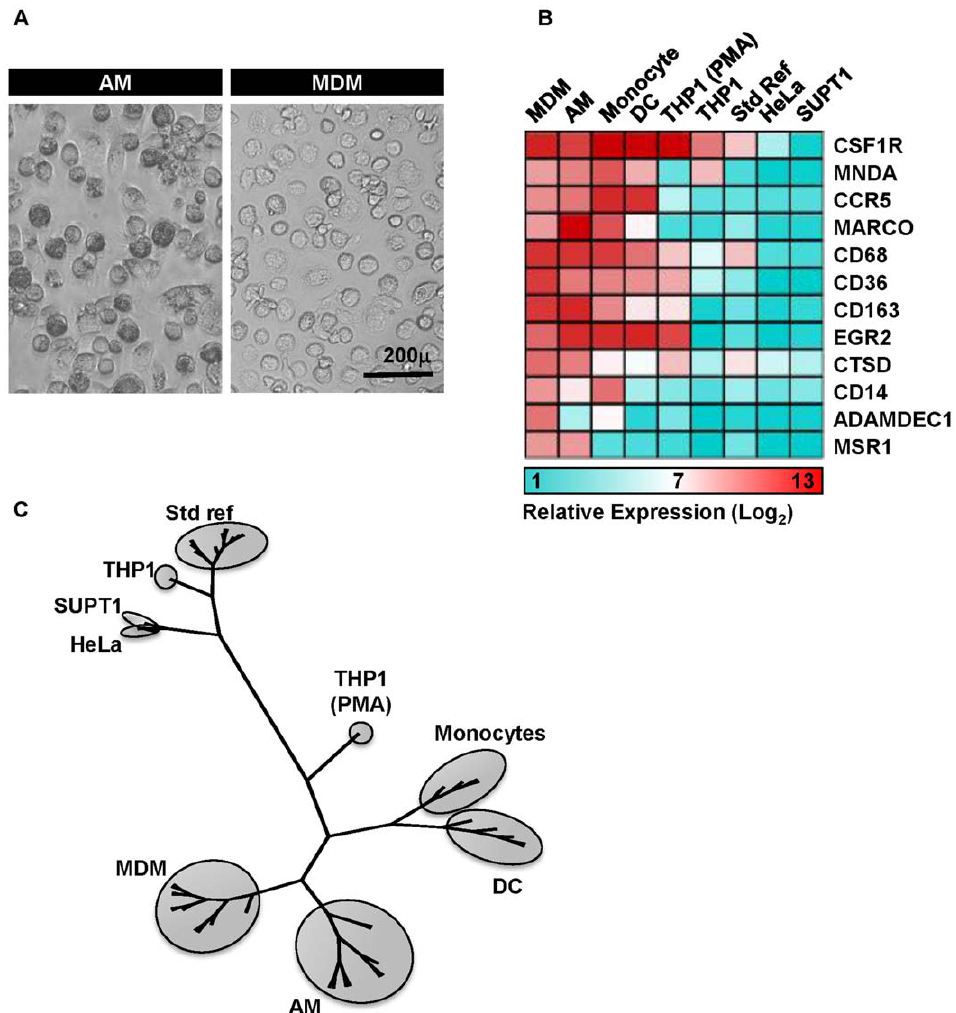
Figure 1. AM and MDM share common gene expression characteristics. (A) AM cultured for 24 hours exhibit similar appearances to MDM (differentiated for seven days) on light microscopy. (B) Mean relative gene expression levels of selected macrophage characteristic genes are comparable in AM (from four donors) and MDM (from eight donors). Many of these genes are also expressed in monocytes (from four donors), and to a lesser extent in DC (from five donors), but not in any of the cell lines. (C) Hierarchical clustering on the basis of macrophage signature genes also shows that AM and MDM transcriptional profiles are closely related, and segregate together with other myeloid cells, distinct from undifferentiated THP1, HeLa and SUPT1 cells and a standard reference RNA